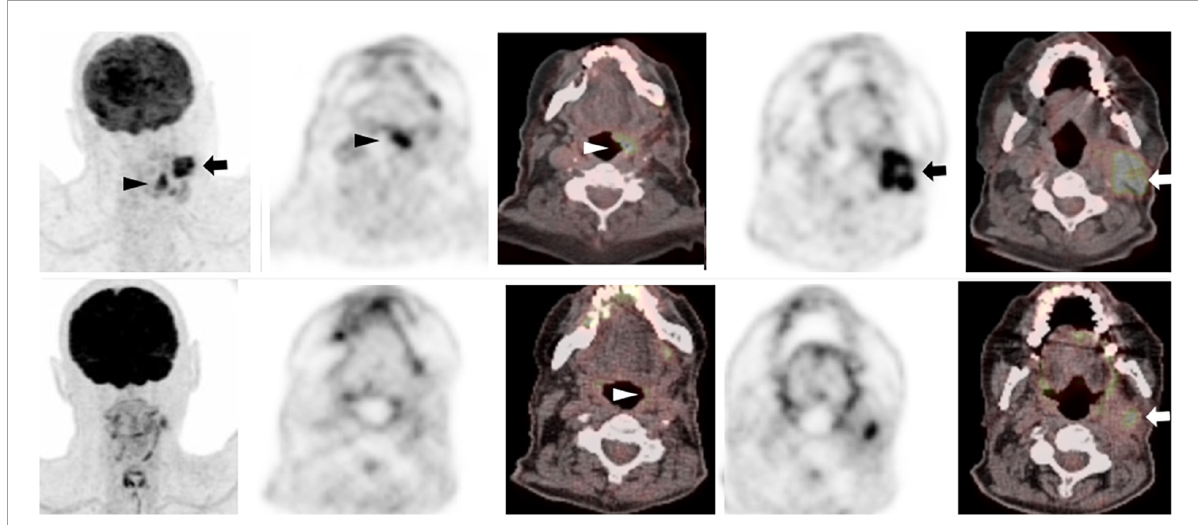
FIGURE4 75-year-old man with left tongue base squamous cell carcinoma. Baseline 18 F-FDG PET/CT ( top row – zoomed MIP image left, axial PET and fused PET/CT image at level of primary tumor (middle columns) and neck level II lymphadenopathy (right columns) show an intensely metabolically active left tongue base tumor (arrowhead) with metabolically active metastatic left neck lymphadenopathy (arrow) . Follow-up PET following radical chemoradiotherapy (corresponding images, bottom row) showed complete metabolic response at the primary tumor (white arrowhead, bottom row) , with a persistent metabolically active left neck lymph node, Hopkins score 5, consistent with residual tumor (white arrow, bottom row)